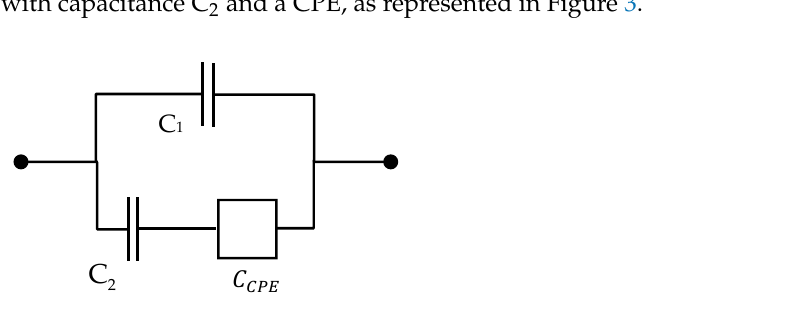
Figure 3. Dielectric counterpart of the mechanical model with a CPE.